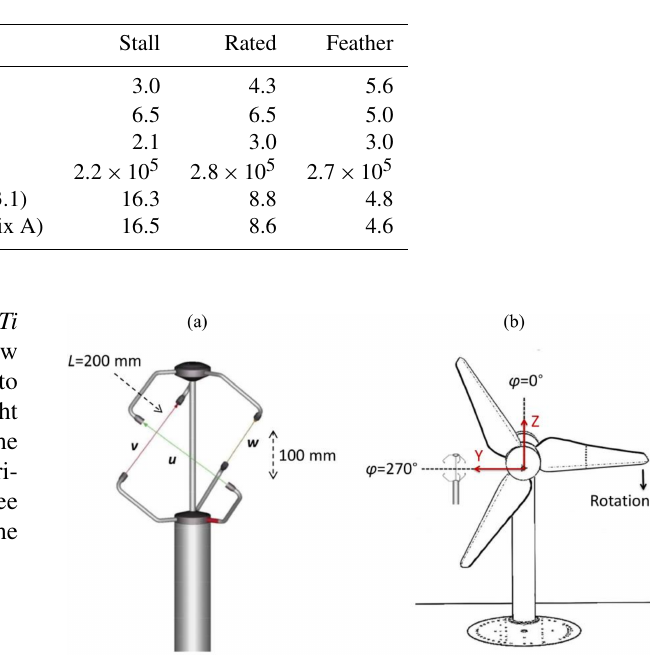
Table 2. Summary of operation points.